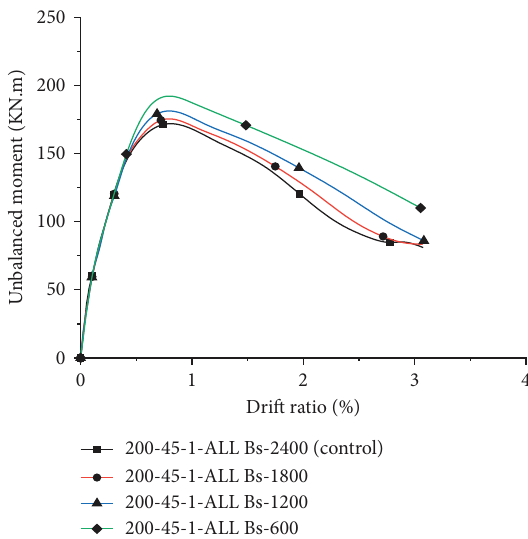
Figure 34: Efect of post-earthquake fre exposure duration on unbalanced moment drift ratio